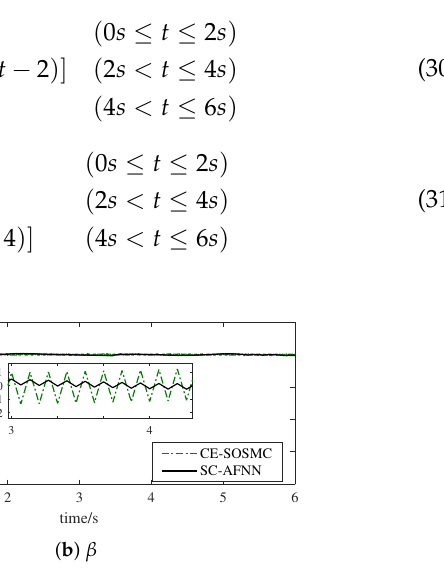
Figure 8. The tracking error curves of the UBSHR’s end-effector (desired trajectory 2). ( a ) Tracking error curves in z -direction (6 s); ( b ) Tracking error curves of β (6 s). Table 2. The numerical values of the steady-state performance and root mean square error (RMSE) (desired trajectory